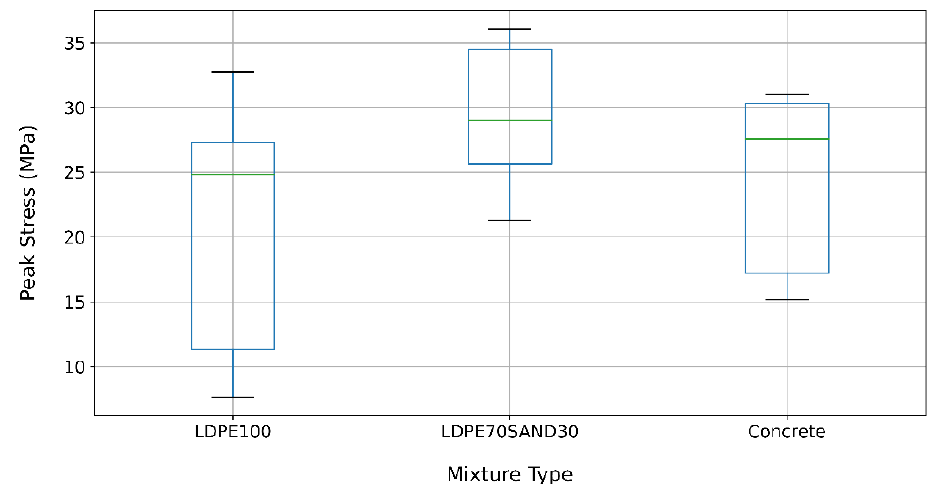
Figure 8. Compressive strength (MPa) of the best mixture obtained from tensile test (LDPE70 Sand30) compared with pure LDPE and concrete.